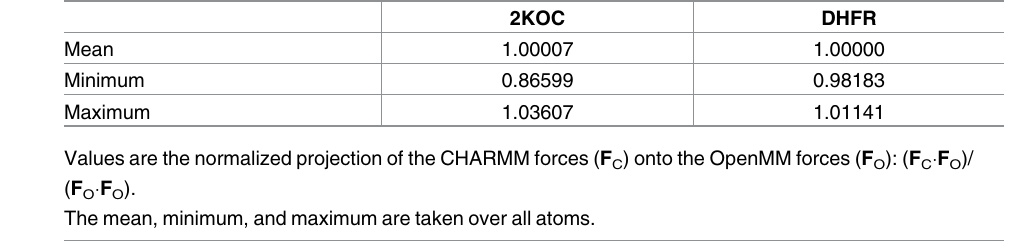
Table 11. Comparison of forces as computed by CHARMM and OpenMM.